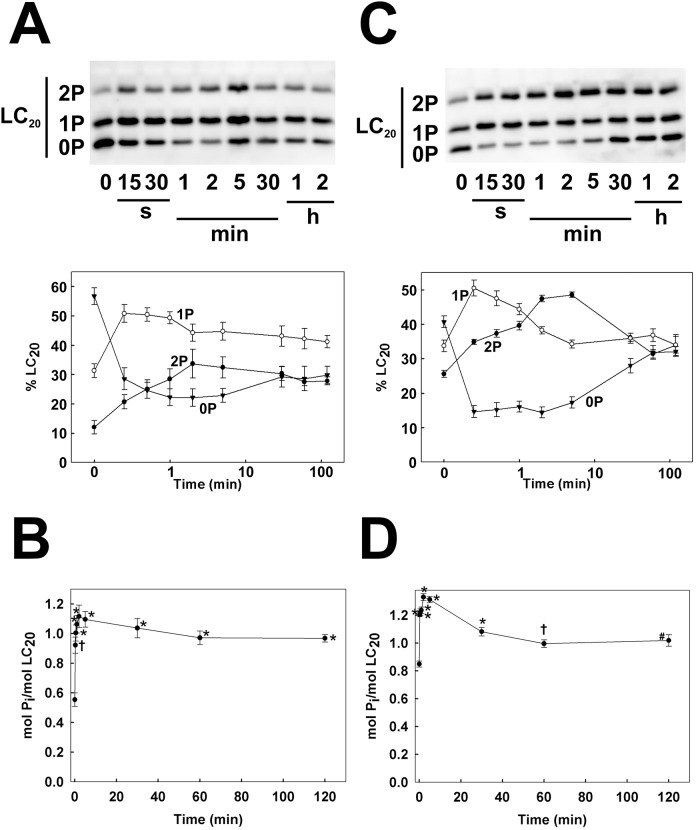
Time courses of serum-induced LC20 phosphorylation in human arterial smooth muscle cells.Human coronary (A, B) and umbilical arterial smooth muscle cells (C, D) were seeded in 4-well plates, serum starved overnight and stimulated with 5% FBS at time zero. Cells were lysed in Laemmli sample buffer at the indicated times of serum stimulation and subjected to Phos-tag SDS-PAGE and western blotting with anti-LC20 to detect unphosphorylated (0P), mono- (1P) and diphosphorylated LC20 (2P). Representative western blots are shown in panels A and C above cumulative quantitative data for each of the LC20 bands. Panels B and D show the time courses of total phosphorylation stoichiometry, calculated as follows: mol Pi/mol LC20 = (1P + 2x2P) / (0P + 1P + 2P). Values indicate the mean ± SEM (n = 7 for panels A and B; n = 6 for panels C and D). Significant differences from the value at time zero are indicated: *p < 0.0001, †p = 0.0001 (B), *p < 0.0001, †p = 0.0023, #p = 0.0004 (D) (Dunnett’s post hoc test).